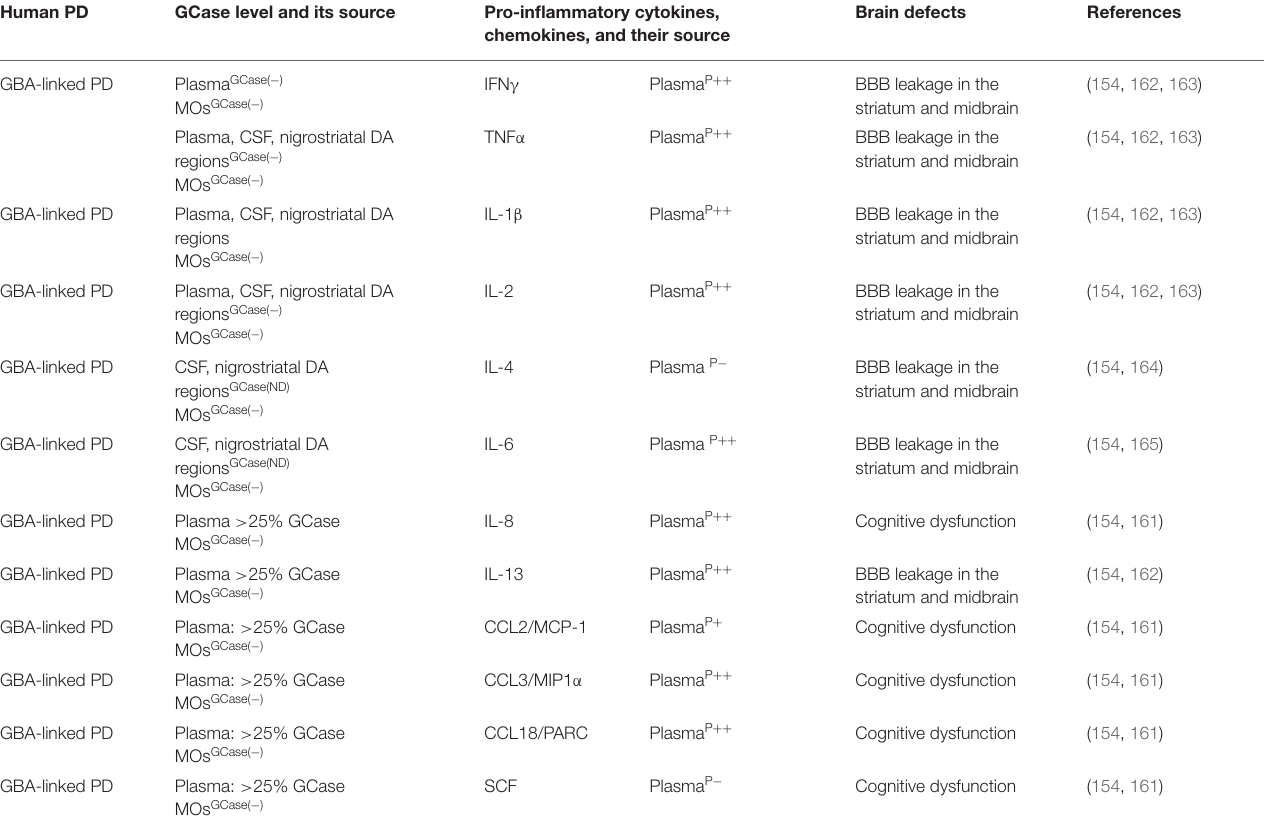
TABLE 3B | Cytokines and their source in the GBA-associated human PD. Human